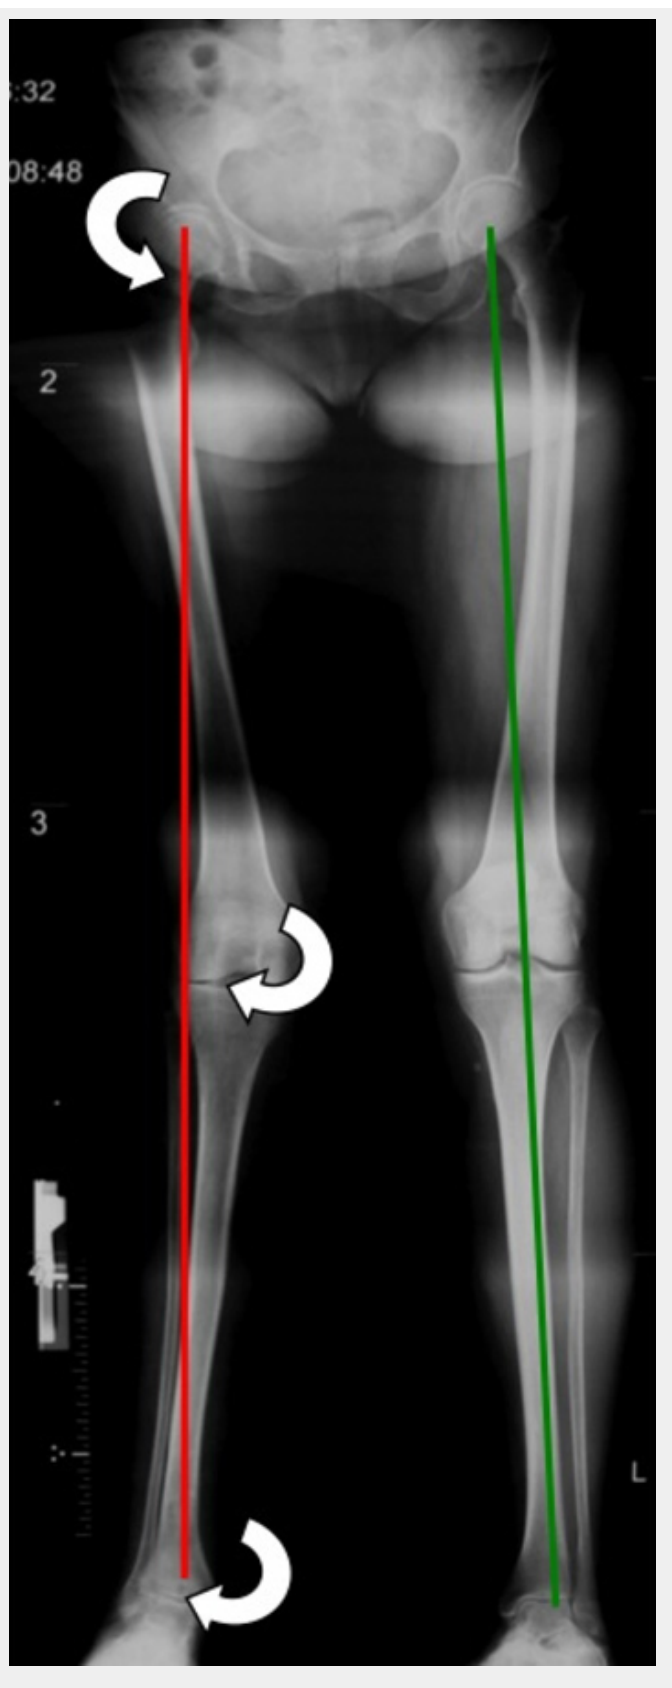
Figure 2 Long leg film with right side genu valgum and advanced ankle arthritis. The white arrows indicate the abduction moments on each joint resulting from the deviated mechanical